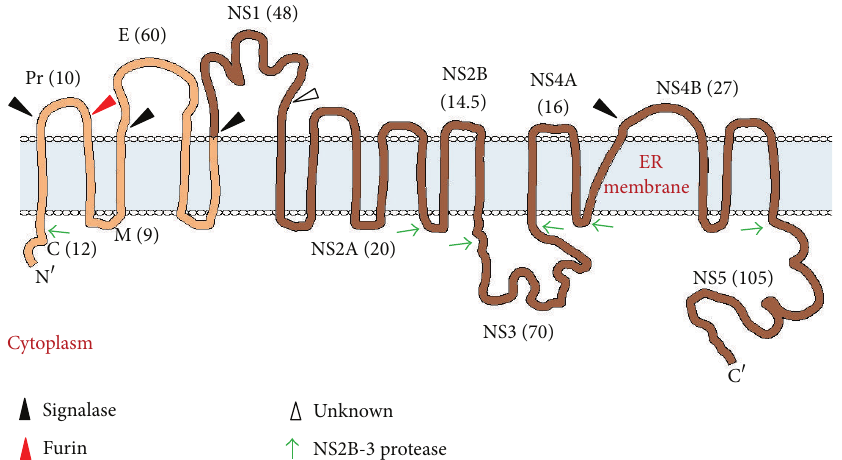
Figure 1: Genome organization and membrane topology of dengue virus. The viral RNA is translated as a single polyprotein consisting of structural (light brown-C, prM, and E) and nonstructural (dark brown-NS1, 2A, 2B, 3, 4A, 4B, and 5) protein components. Symbols C, prM, E, NS, and PM denote capsid protein, precursor membrane protein, envelope protein, nonstructural proteins, and plasma membrane, respectively. This single polyprotein then gets processed by viral (green arrow) and host (black arrow) proteases. The structural proteins (prM and E) remain anchored on the luminal side of the ER membrane. The C protein is anchored on the cytoplasmic side of ER membrane. prM is later cleaved by furin (red arrow) in the TGN into the pr peptide and M protein. The NS proteins are mainly processed by NS2B-NS3 (viral protease) in the cytoplasm. NS2A/2B and NS4A/4B are transmembrane proteins and thus stay anchored in the ER. The approximate molecular weight (in kDa) of each protein has been indicated in